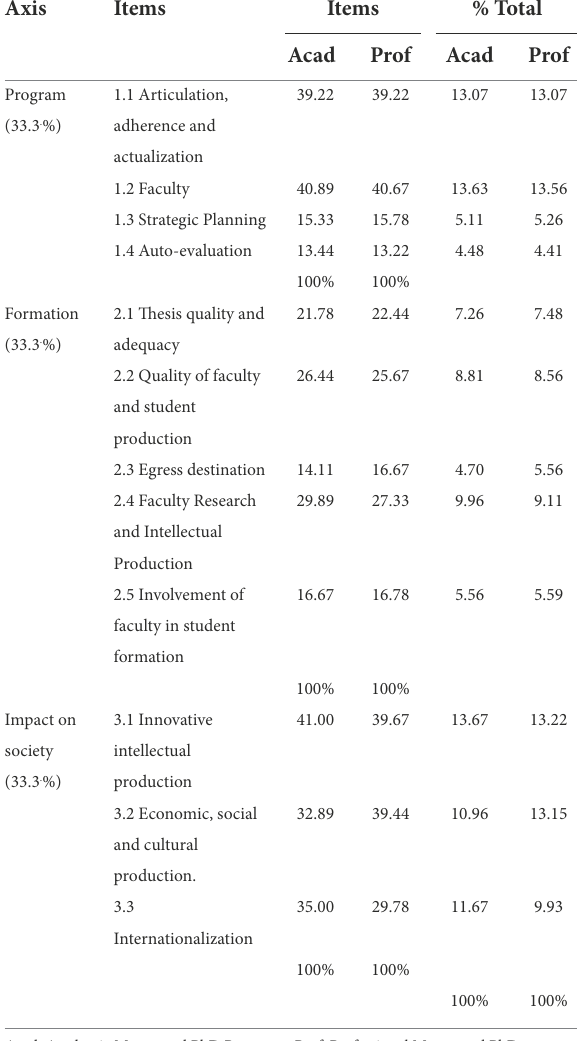
TABLE 4 Number of Indicators per evaluation